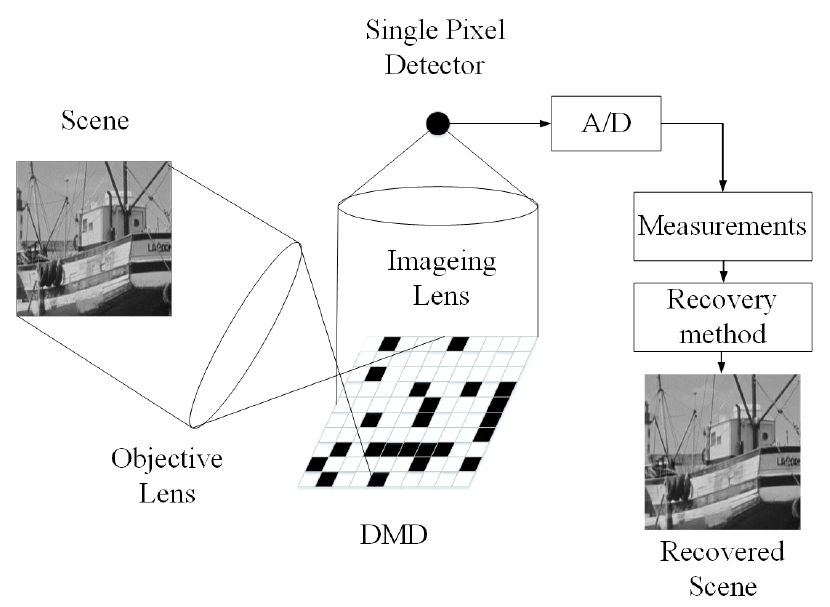
Figure 1. Architecture of the single-pixel camera